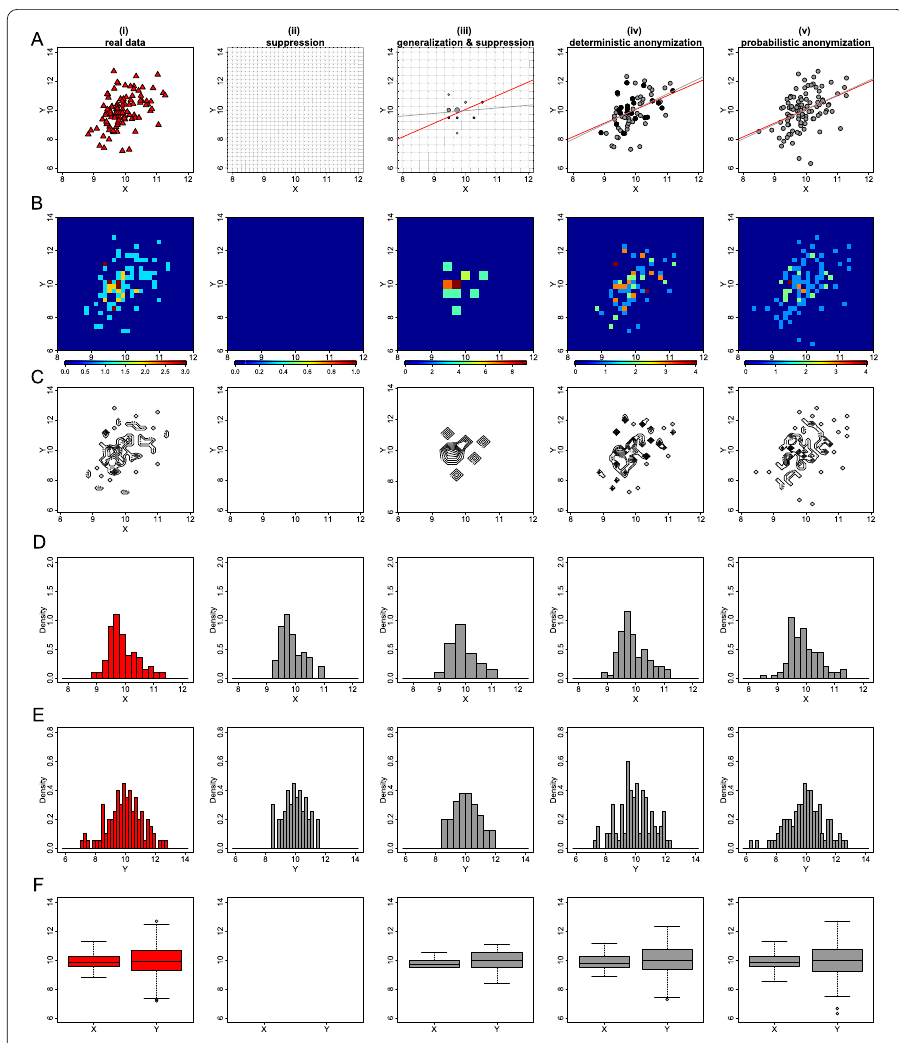
Figure 18 The performance of the techniques applied in a sample of 100 observations. From top to bottom we demonstrate the scatter plots ( A ), heat map plots ( B ), contour plots ( C ), histograms of X ( D ) and Y ( E ), and box plots ( F ) for real data (i), suppressed data (ii), generalized and suppressed data (iii), deterministically anonymized data (iv) and probabilistic anonymized data